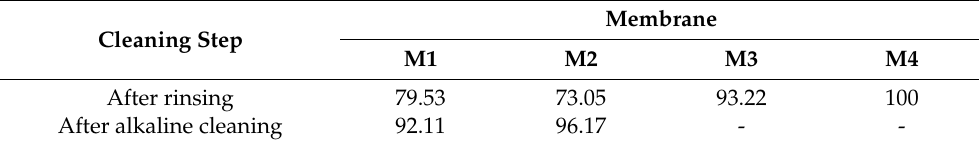
Table 9. Recovery of permeate flux (%) after cleaning procedure.